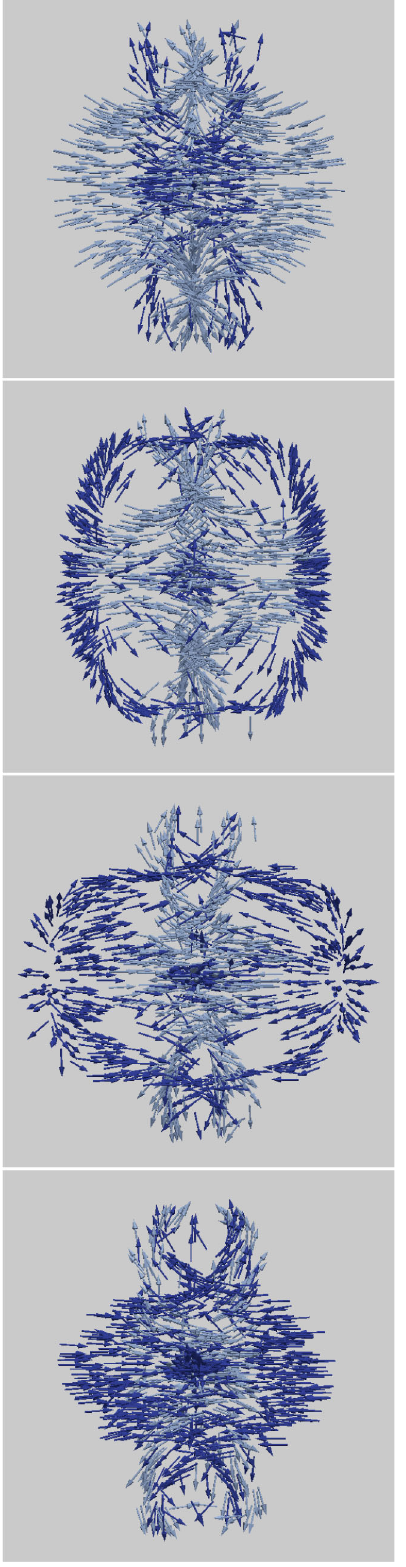
FIG. 10. Evolution of an ion cloud (dark blue: H þ 2 , light blue: CH þ 4 ) in the field of electrodes with a voltage of − 2700 V after 0 . 23 μ s, 0 . 38 μ s, 0 . 54 μ s and 0 . 69 μ s (from top).